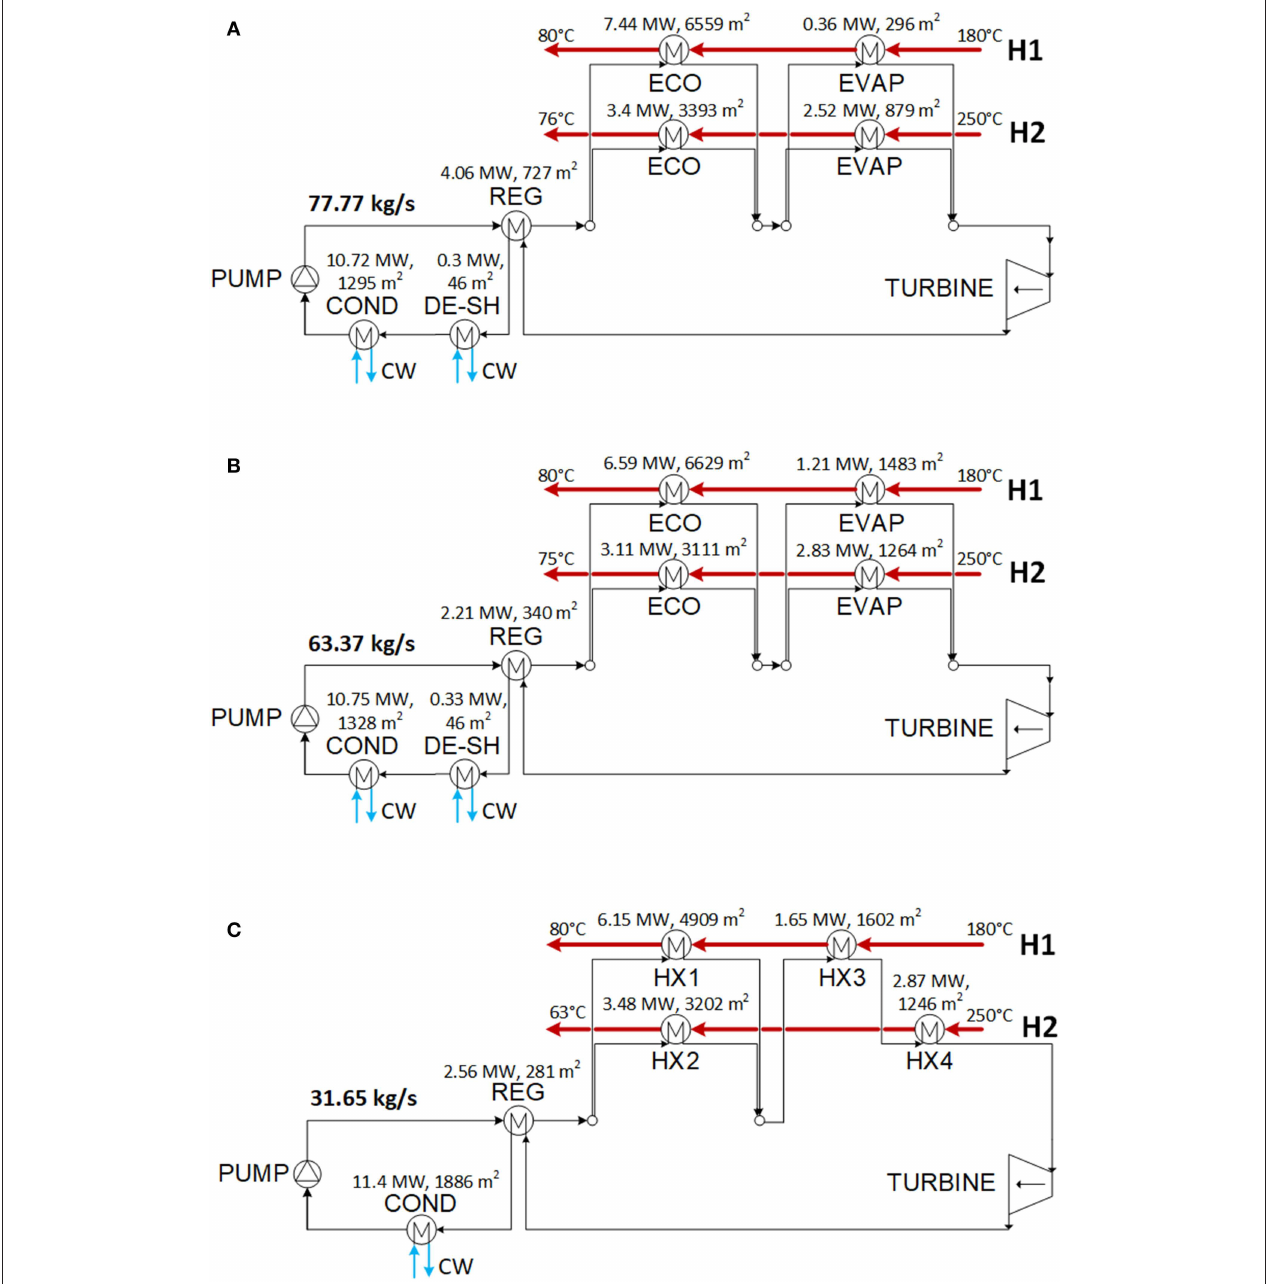
FIGURE 7 | Optimized schemes of the optimal solutions found with fluid RE347mcc (A) , R1336mzz (B) , and isobutane/isopentane (C) for the electricity price equal to 140 $/MWh.